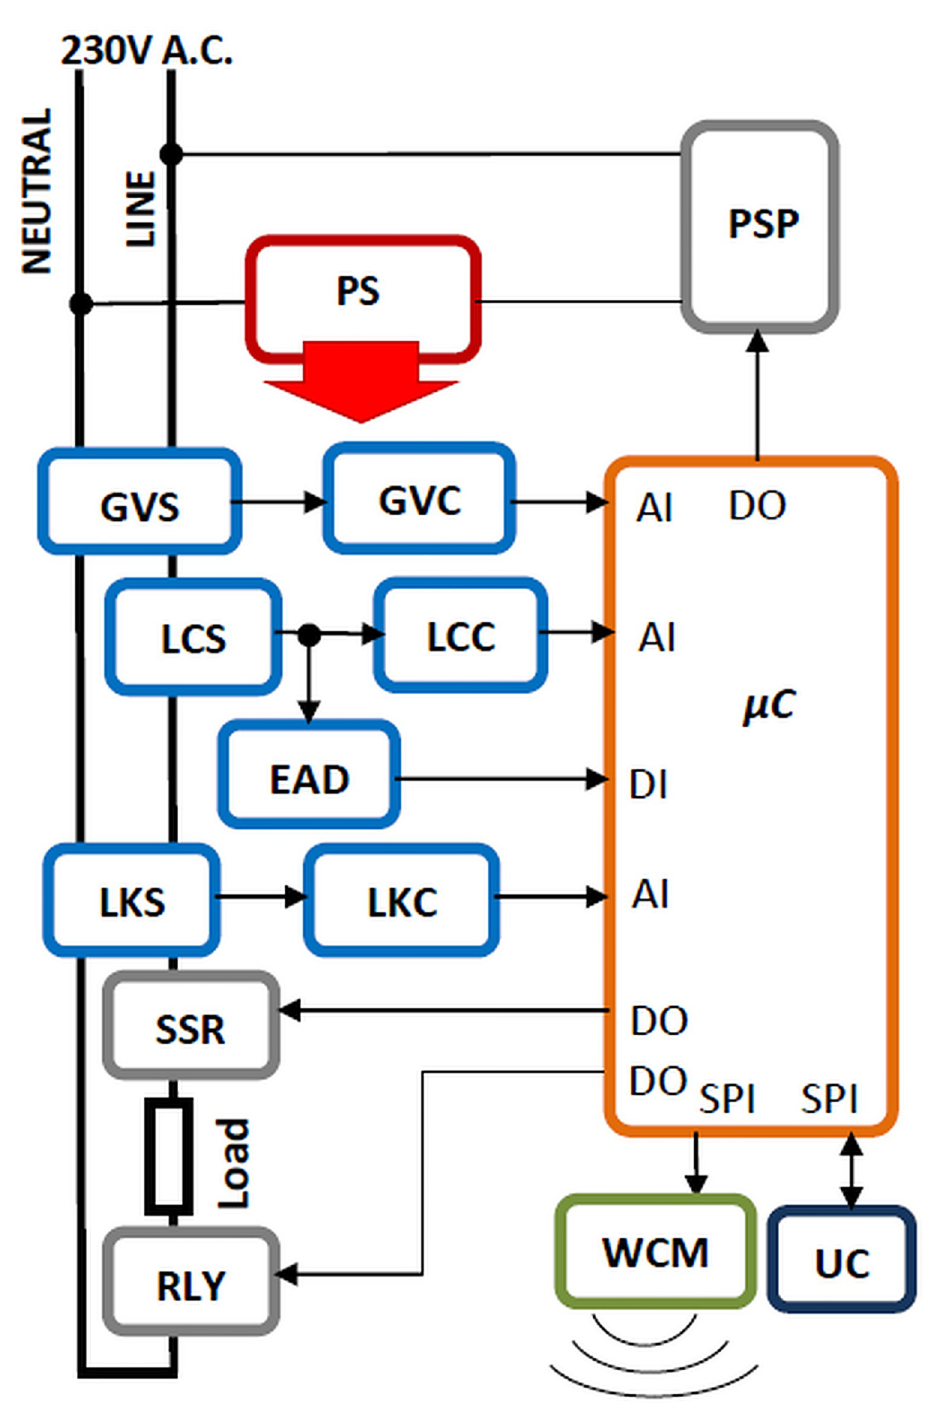
Fig 2. Internal architecture of the protection